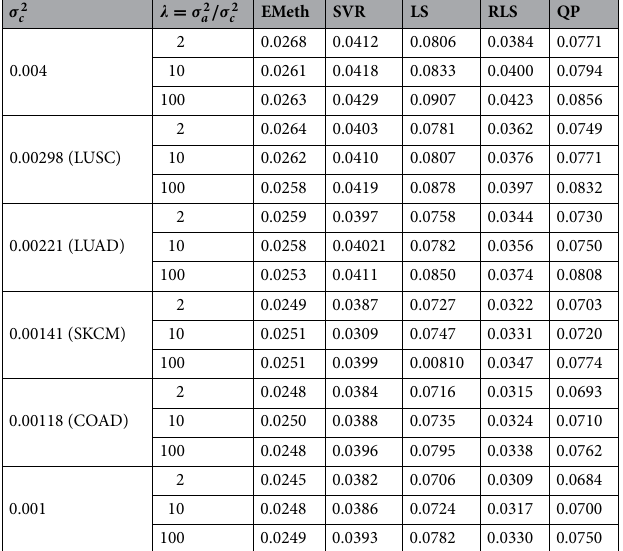
2 c , the noise level for